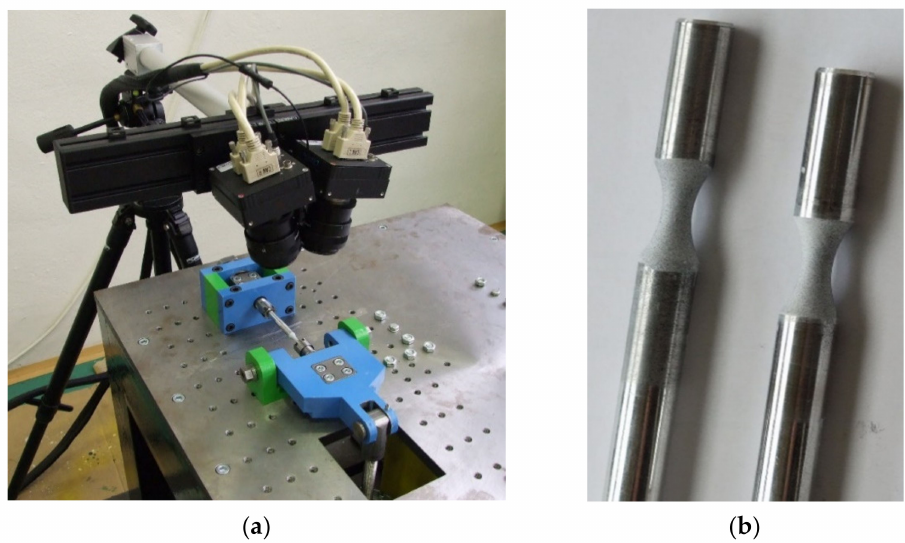
Figure 19. ( a ) Scanning the specimen surface by the ARAMIS system; ( b ) the surface sprayed with reflective paint.